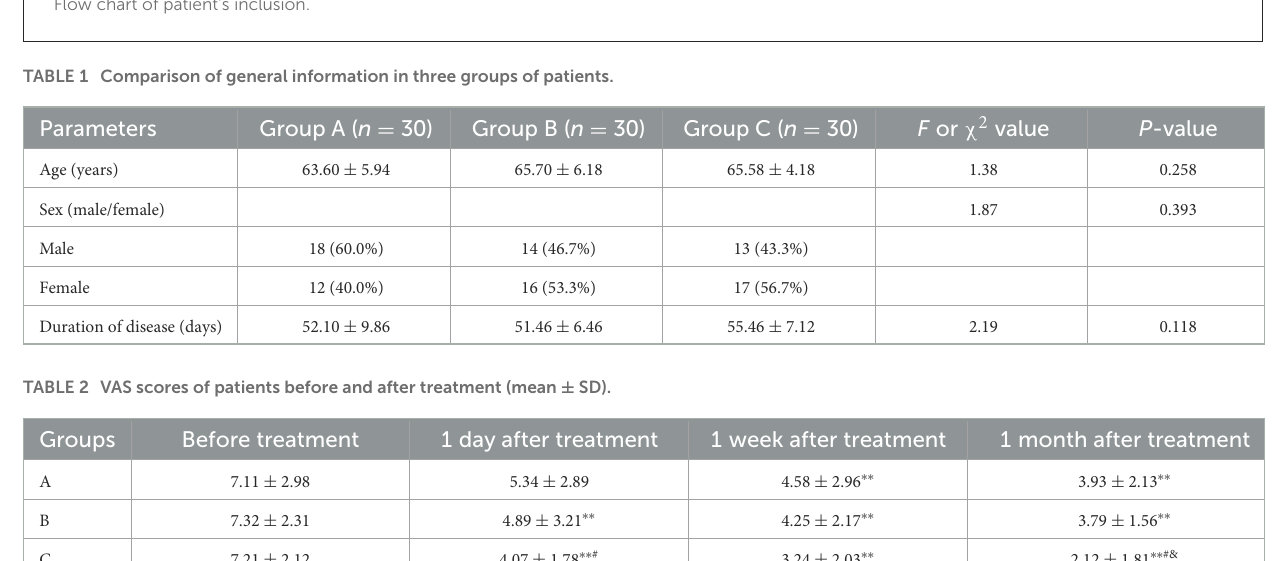
FIGURE5 Flow chart of patient’s inclusion.